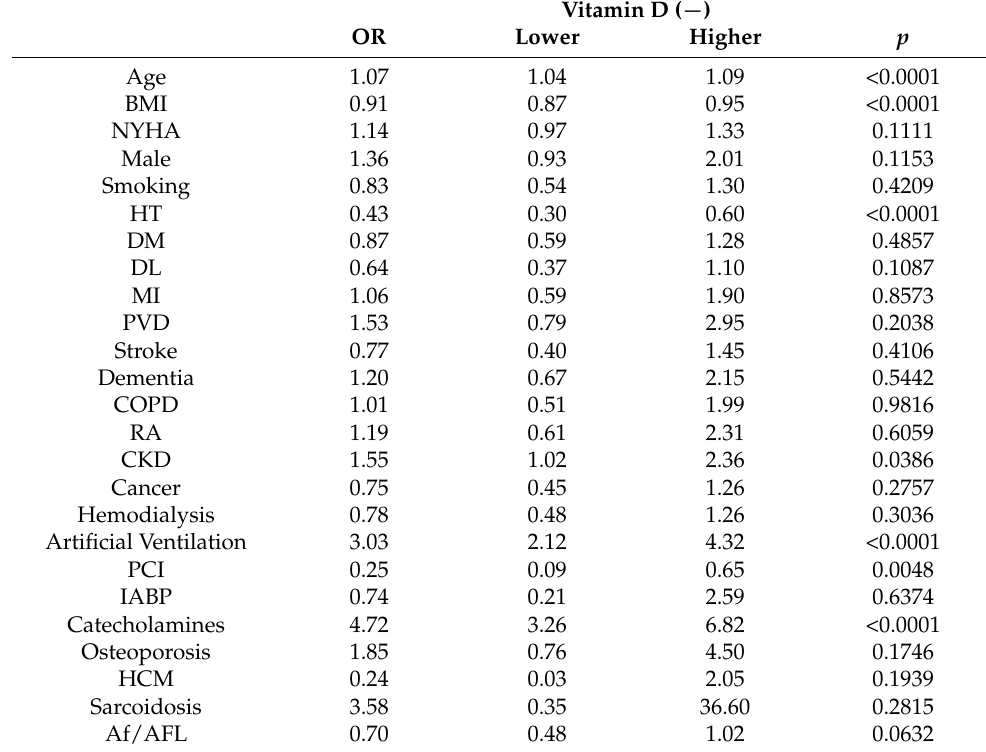
Table 3. Cont. C : In patients without vitamin D supplementation. See abbreviations in Table 1.